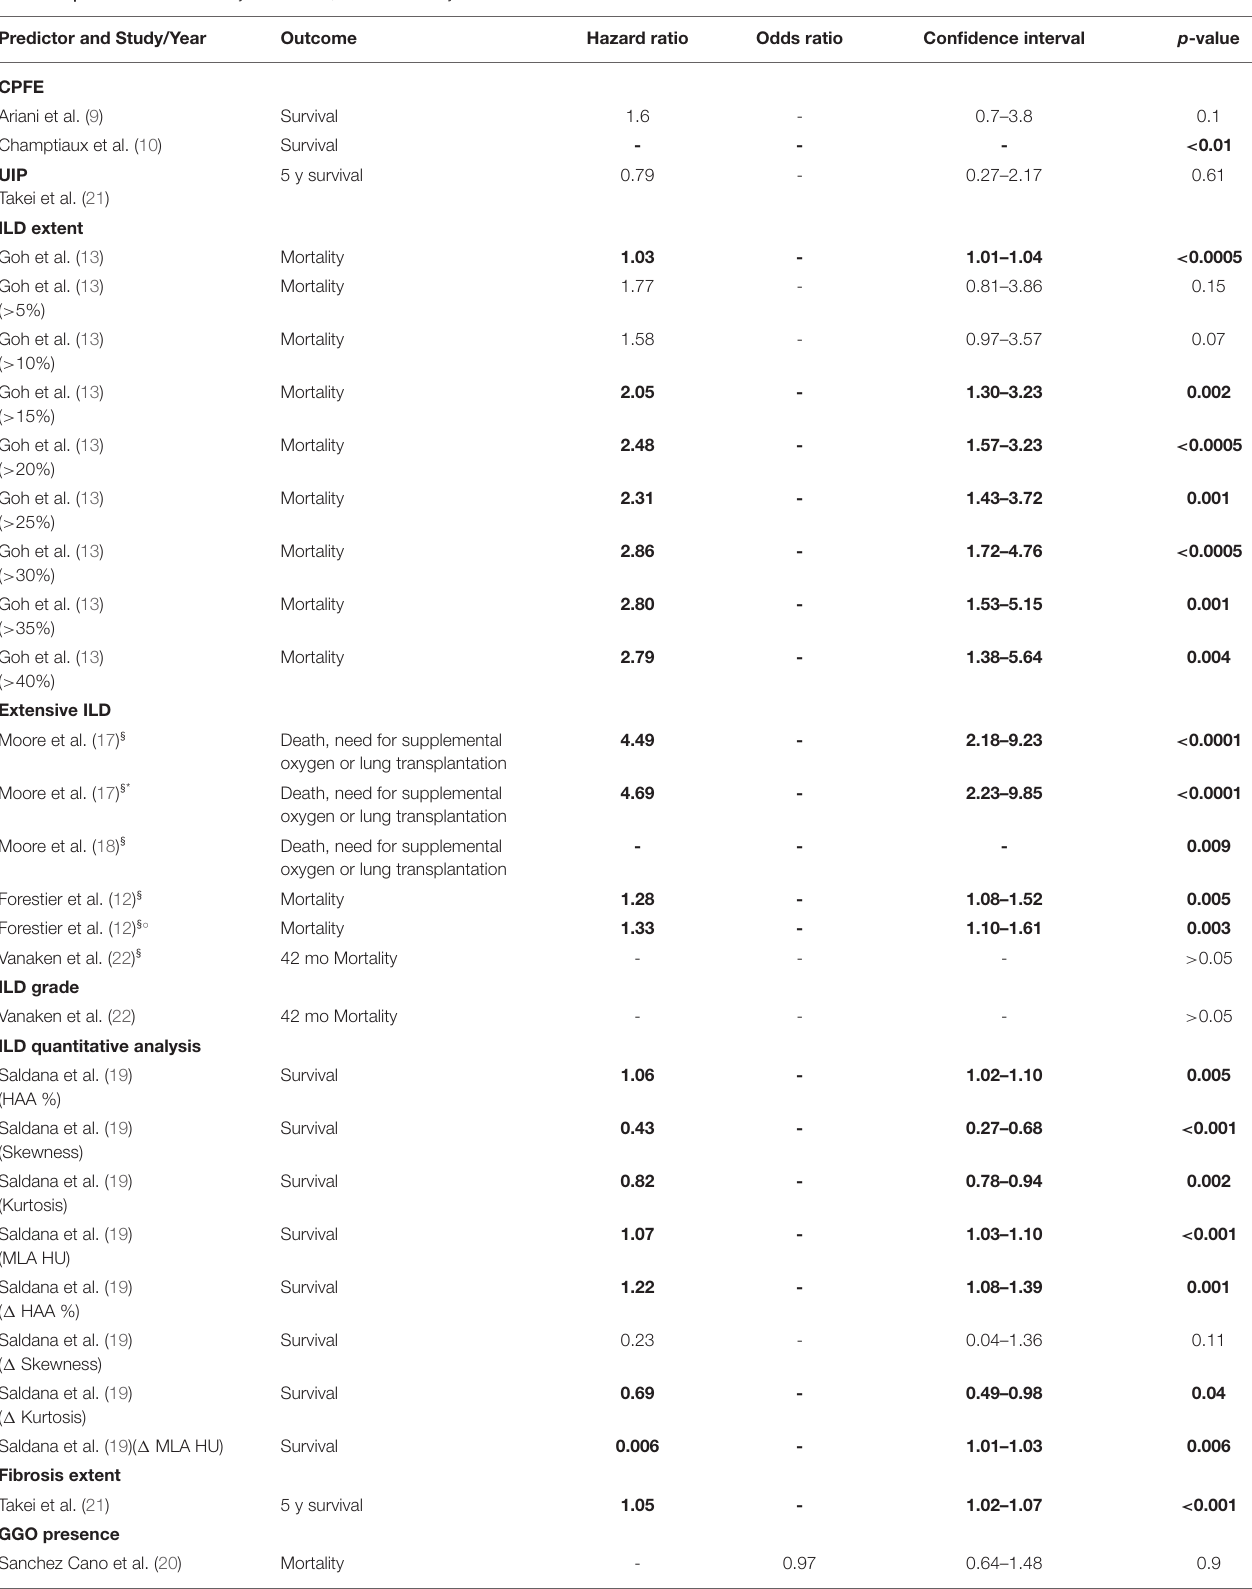
TABLE 2 | Predictors of mortality in ILD-SSc, univariate analysis. Predictor and Study/Year Outcome Hazard ratio Odds ratio Confidence